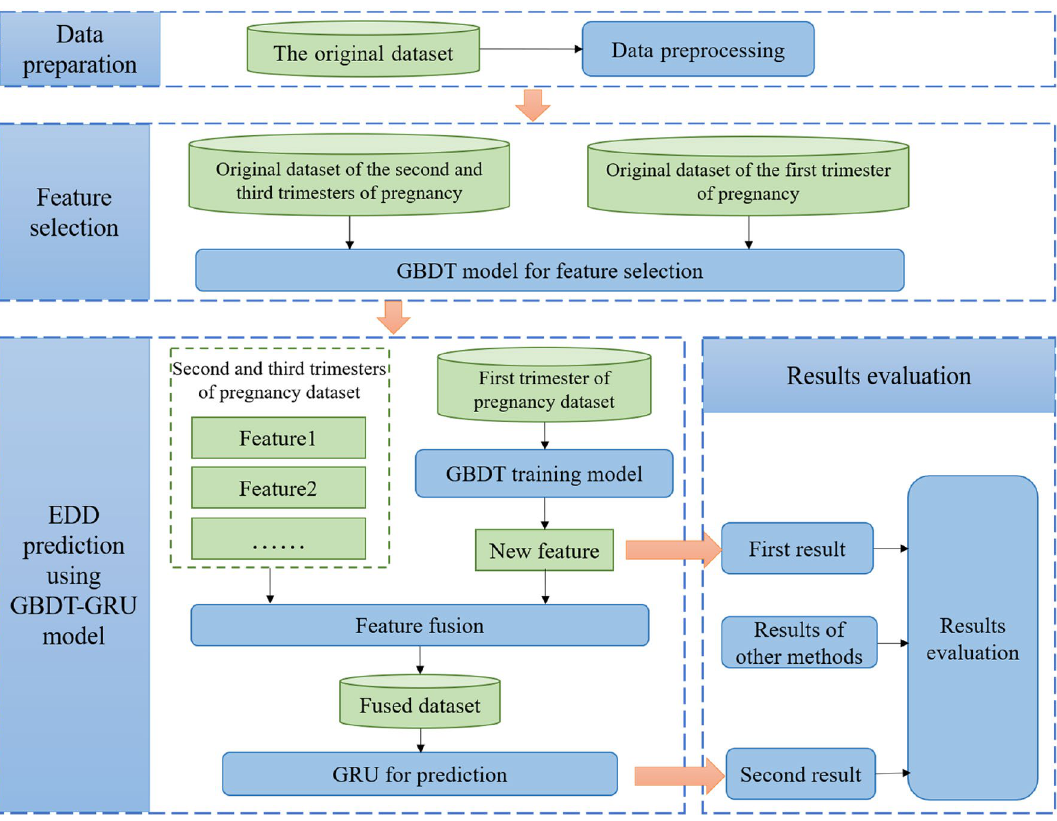
Figure 1. GBDT-GRU framework for the estimated date of